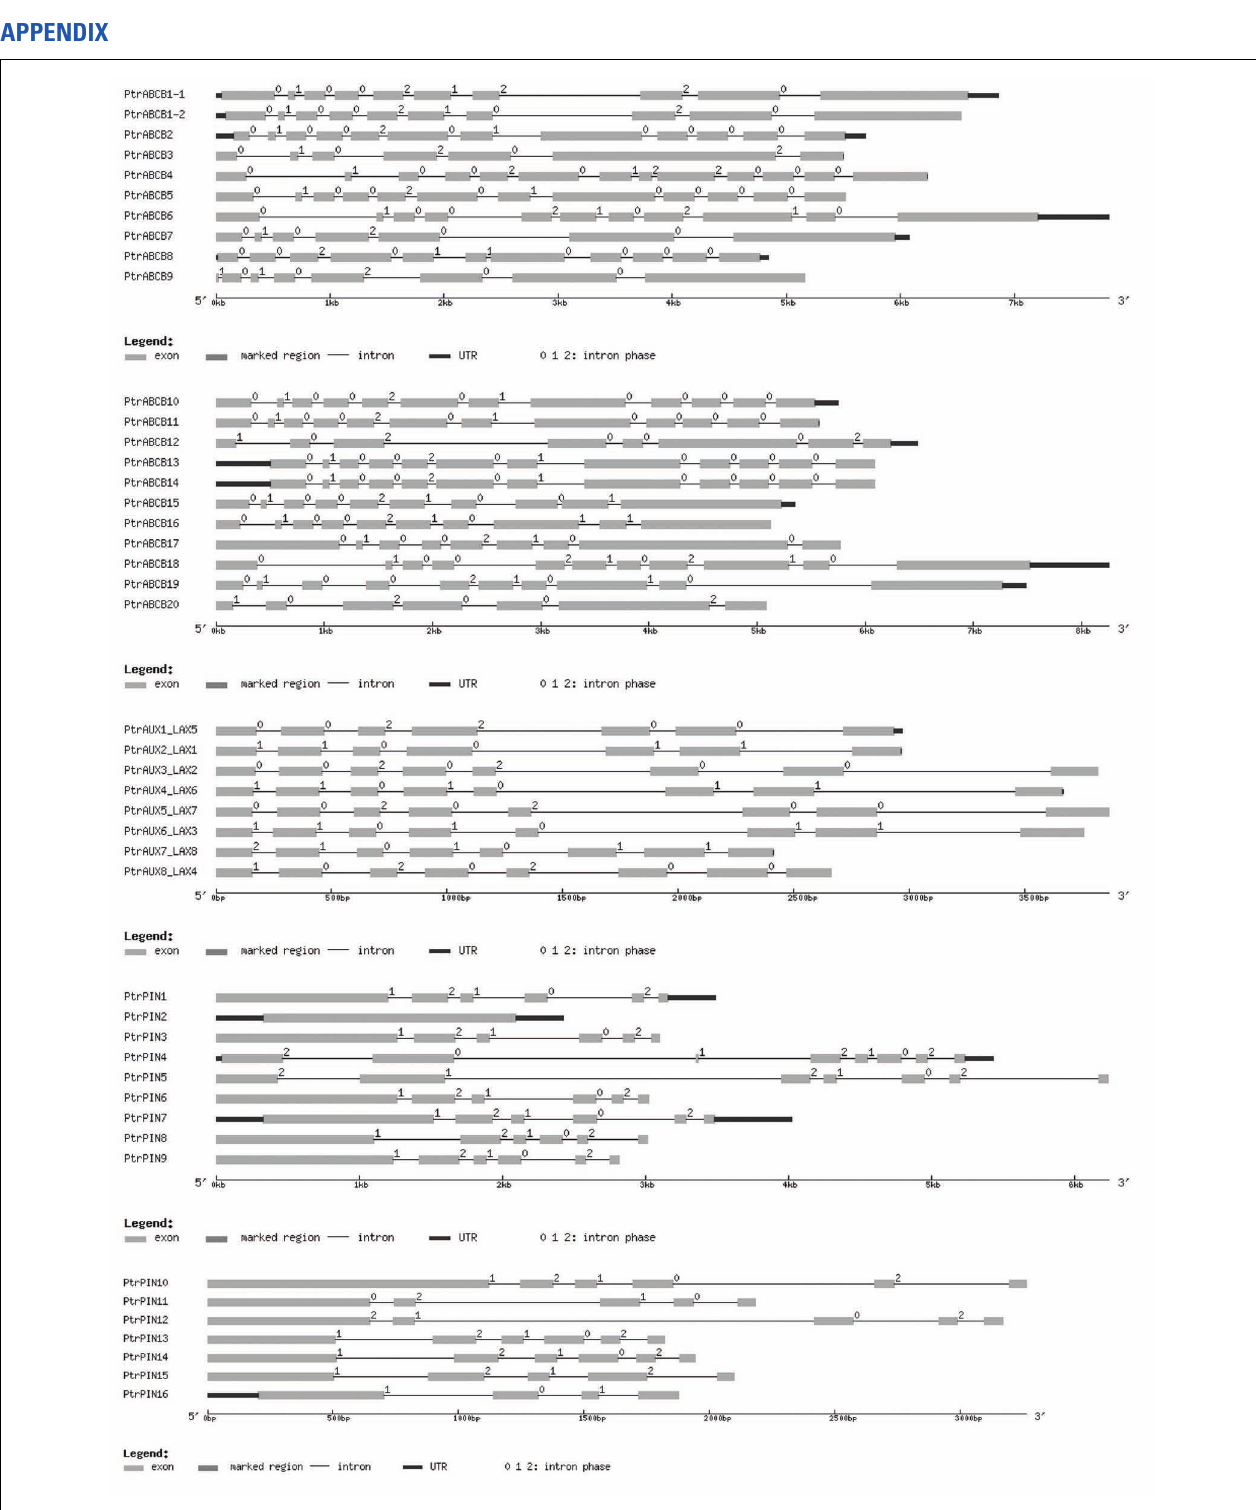
FIGUREA1 | Intron–exon structure of PIN , AUX/LAX , and ABCB genes from Populus trichocarpa.